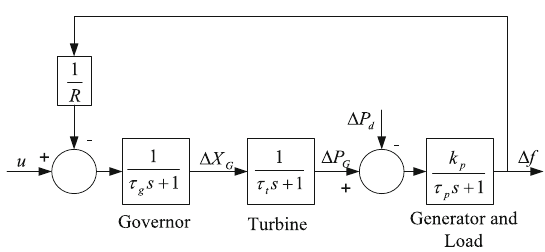
Fig. 2 Linearized model of single area power